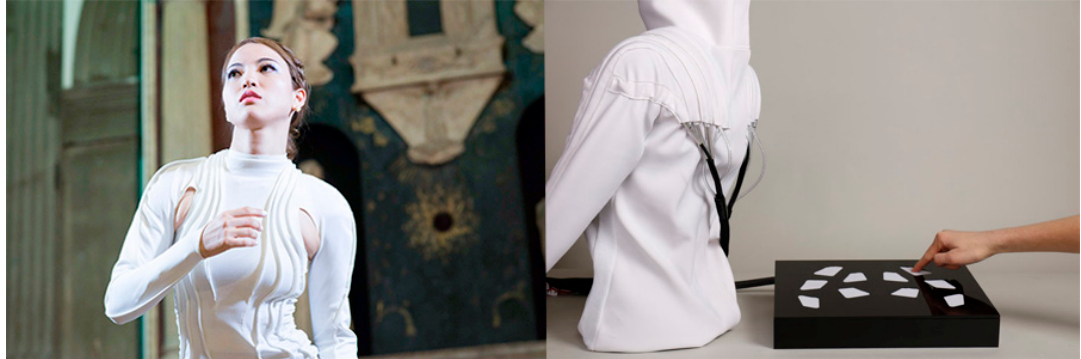
Figure 1. WIM haptic dress by J. Kamei, K. McCambridge and J. Boast. Courtesy J. Kamei.